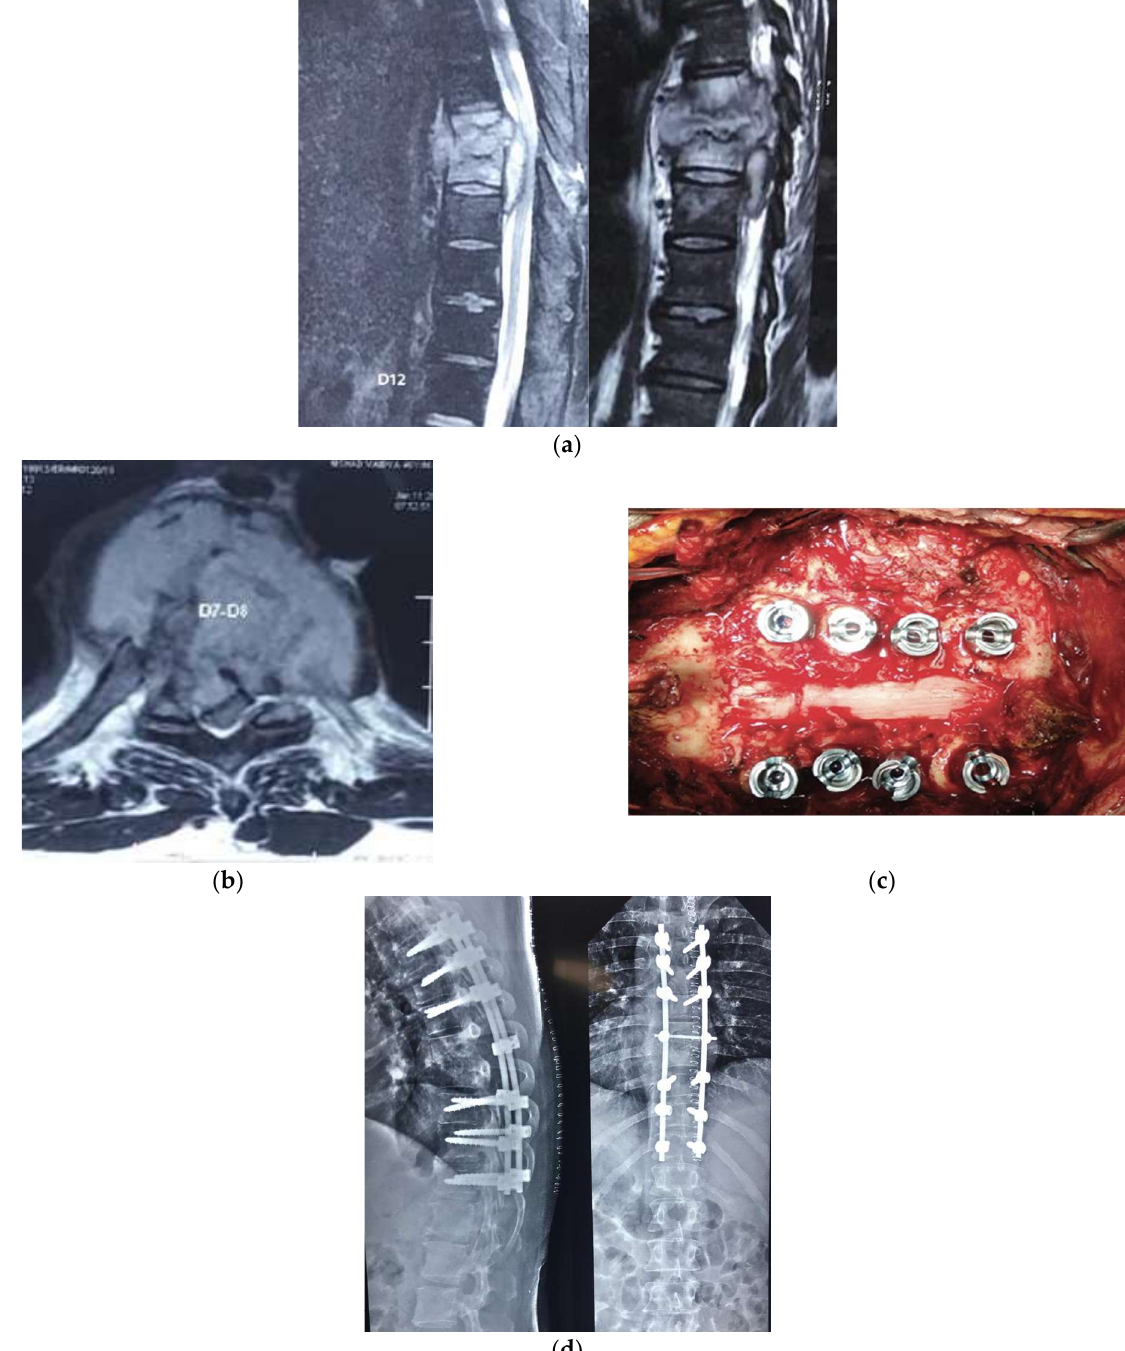
Figure 3. ( a ) Shows tubercular abscess on Sagittal cuts of the MRI; ( b ) shows the axial cut of the lesion; ( c ) shows the intraoperative image of the posterior decompression and stabilization; ( d ) shows the post-operative X-ray of the posterior construct comprising pedicle screws, rods, and the cross-connector.